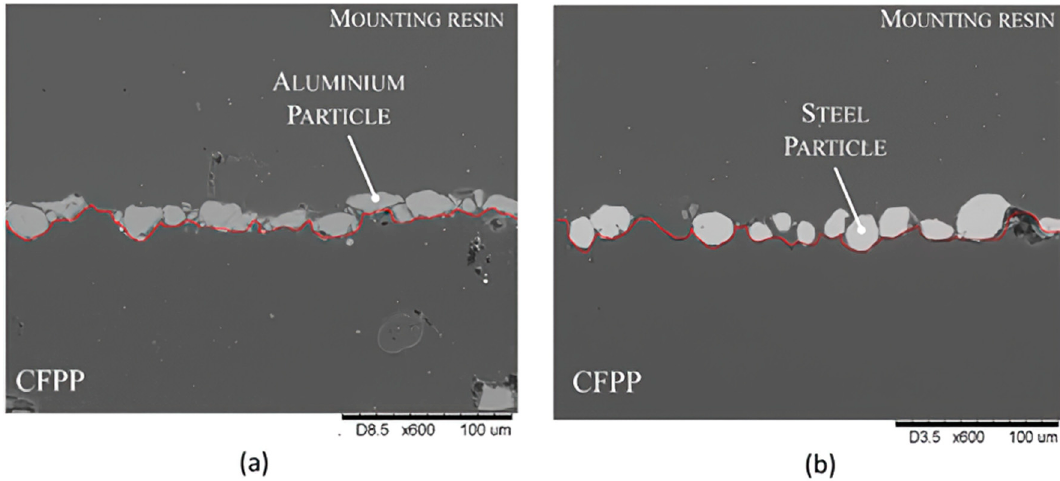
Figure 4. SEM micrographs of cross-sections of the specimens CFPP-Al 1 and CFPP-AISI 1 . ( a ) CFPP substrate with aluminium coating, ( b ) CFPP substrate with steel coating.